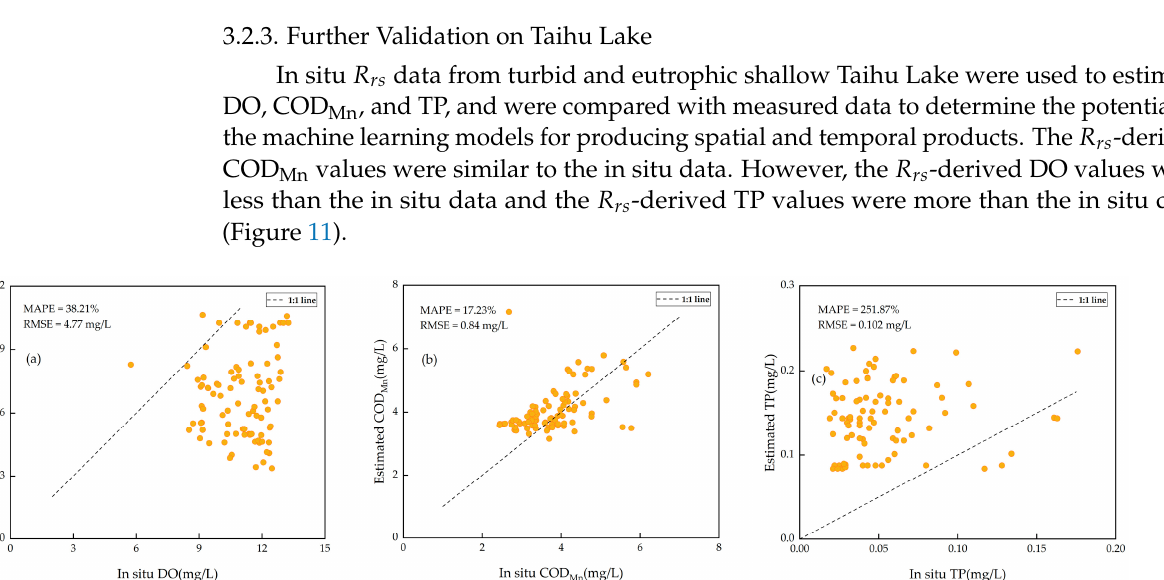
Table 5. Performance of all machine learning models.